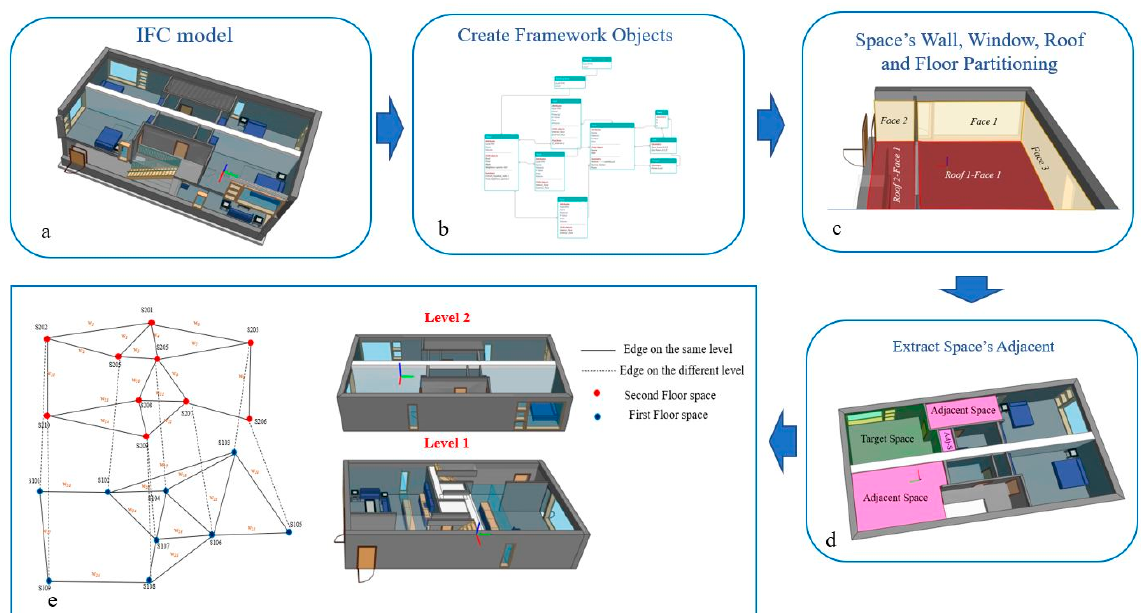
Figure 12. The steps of generating a BECE space-based graph from the IFC model in test case 1.